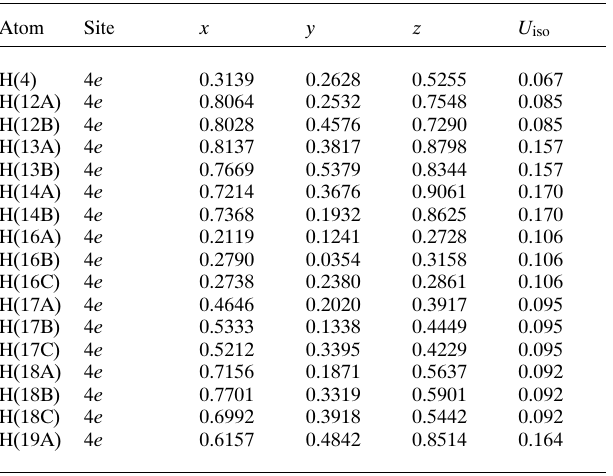
Table 2. Atomic coordinates and displacement parameters (in Å 2 )